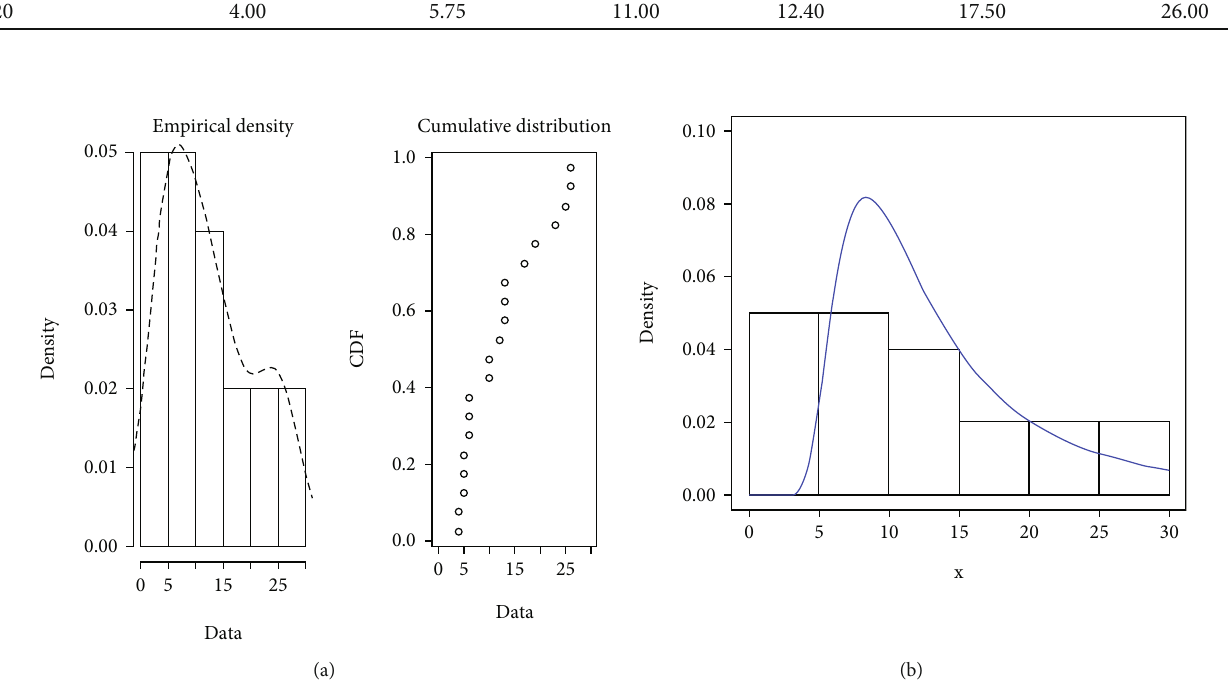
Table 3: Summary statistics of the data set about the time between break down of electric feeders. Sample size